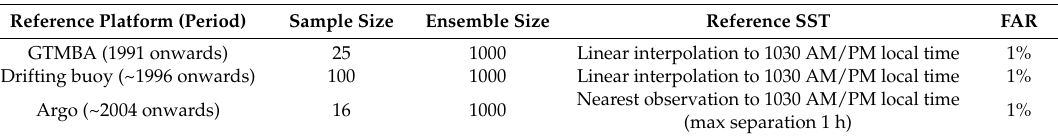
Table 3. Summary of the analyses performed using the PMT. The FAR column indicates the specified false alarm rate used in the tests.